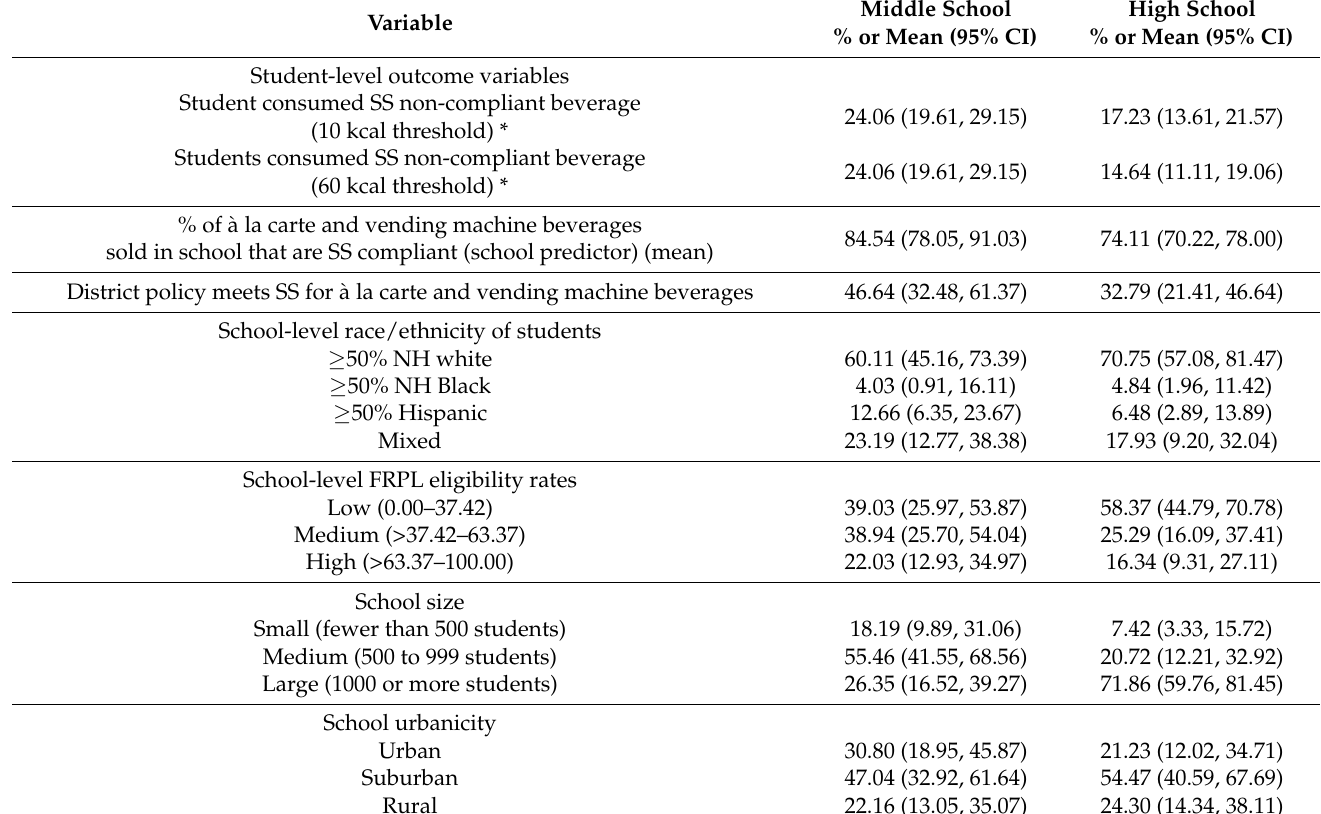
Table 1. Survey-weighted characteristics of the analytic sample by school